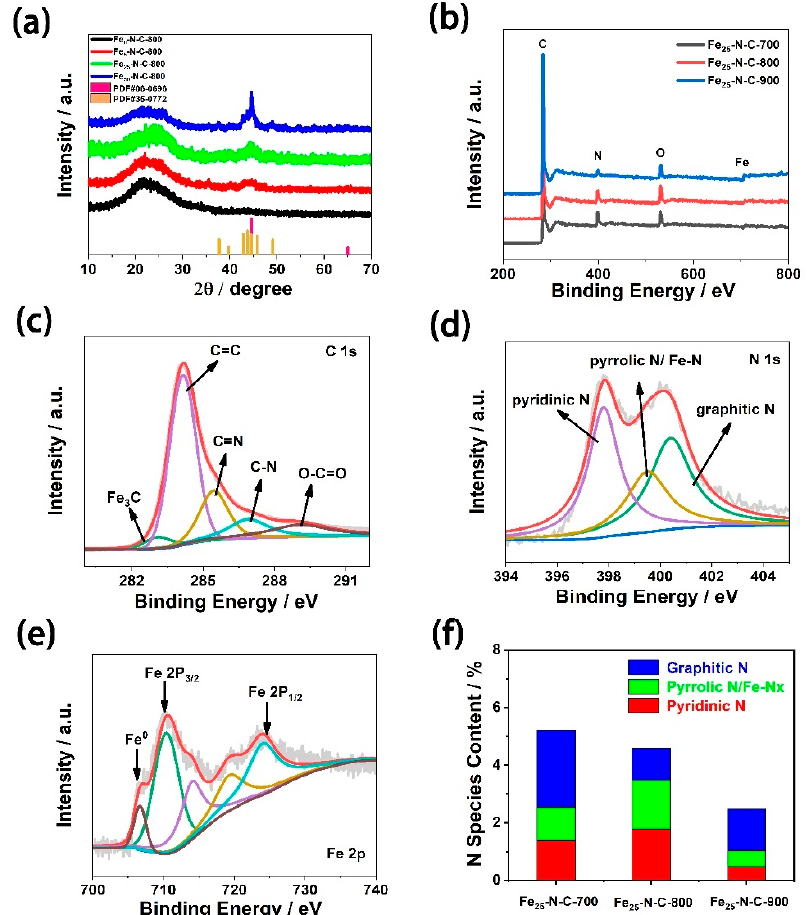
Figure 3. ( a ) XRD of Fe X -N-C-800 (X = 0, 5, 25, 50 mg); ( b ) XPS spectra of Fe 25 -N-C-Y (Y = 700, 800, 900 ◦ C); ( c ) XPS C 1s spectra of Fe 25 -N-C-800; ( d ) XPS N 1s spectra of Fe 25 -N-C-800; ( e ) XPS Fe 2p